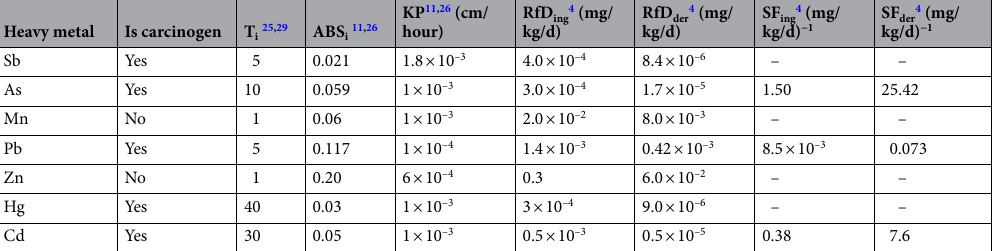
(Table 1). ABS i is the absorption factor of the stomach and intestines (Table1). F is the ratio of the skin contact